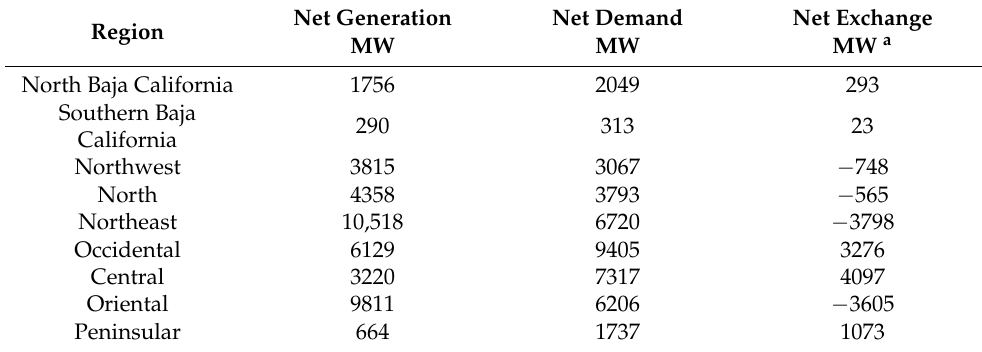
Table 1. Energy Analysis for different